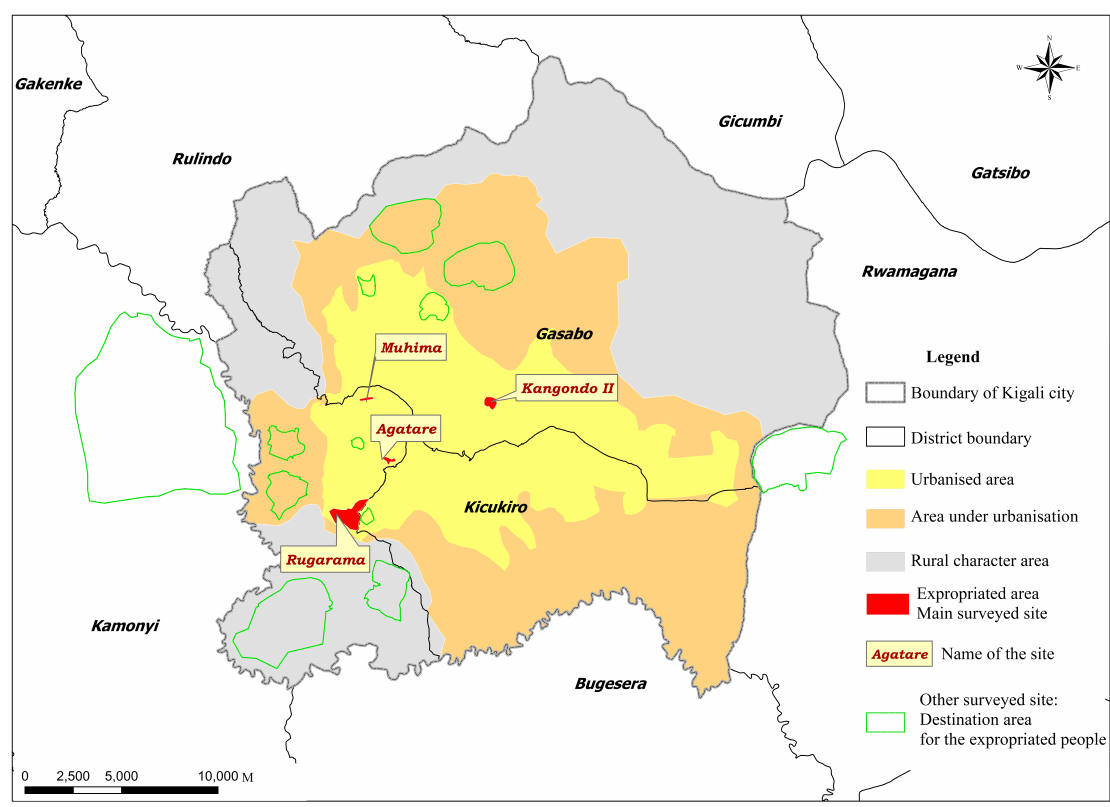
Figure 1. Figure1.This is a figure, Schemes follow the same formatting. If there are multiple panels, Figure 1. Surveyed sites.Data source: Field work; NISR and CGIS-UR they should be listed as: ( a ) Description of what is contained in the first panel. ( b ) Description of what is contained in the second panel. Figures should be placed in the main text near to the first time they are cited. A caption on a single line should be centered.